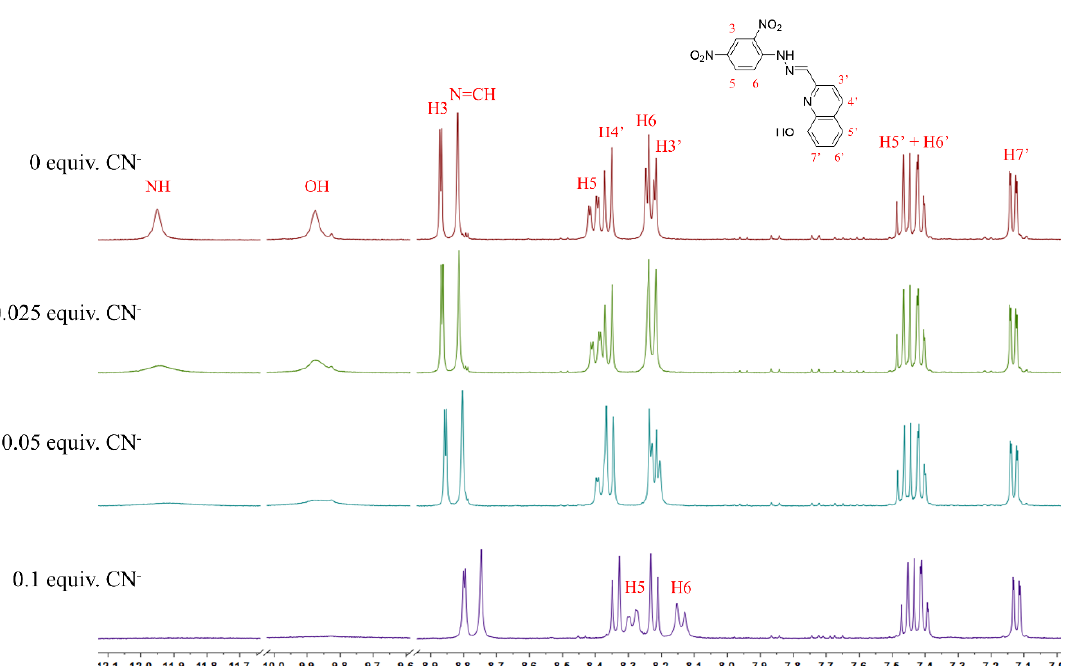
Figure 8. NMR titration of compound 3b with F − in DMSO- d6 .